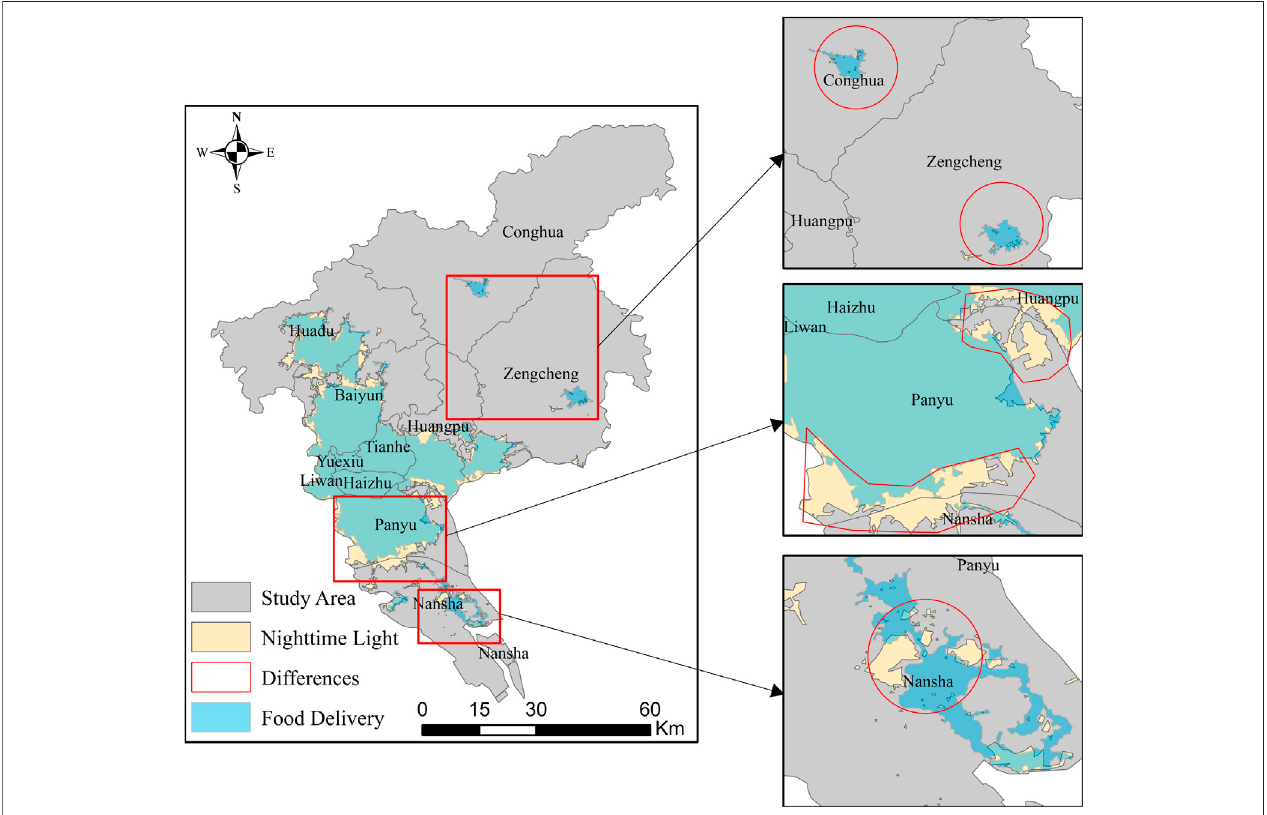
FIGURE 6 | Comparison of identi fi cation results (The differences in urban and rural spatial areas identi fi ed by NTL data and food delivery data are shown in the fi gure, including signi fi cant differences in central urban area, urban and rural fringe and rural-urban fringe zone).